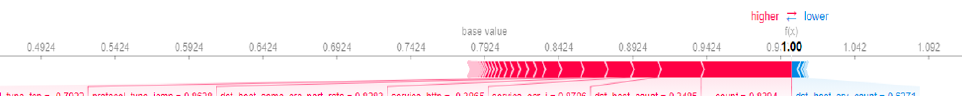
Figure 6. SHAP local explanation of a DOS